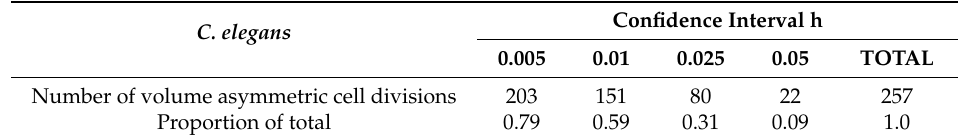
Table 2. Number and proportion of cell divisions above confidence interval threshold (see Methods) for asymmetric cell divisions. Data represents all divisions (N = 257) in a pre-hatch C. elegans lineage tree.